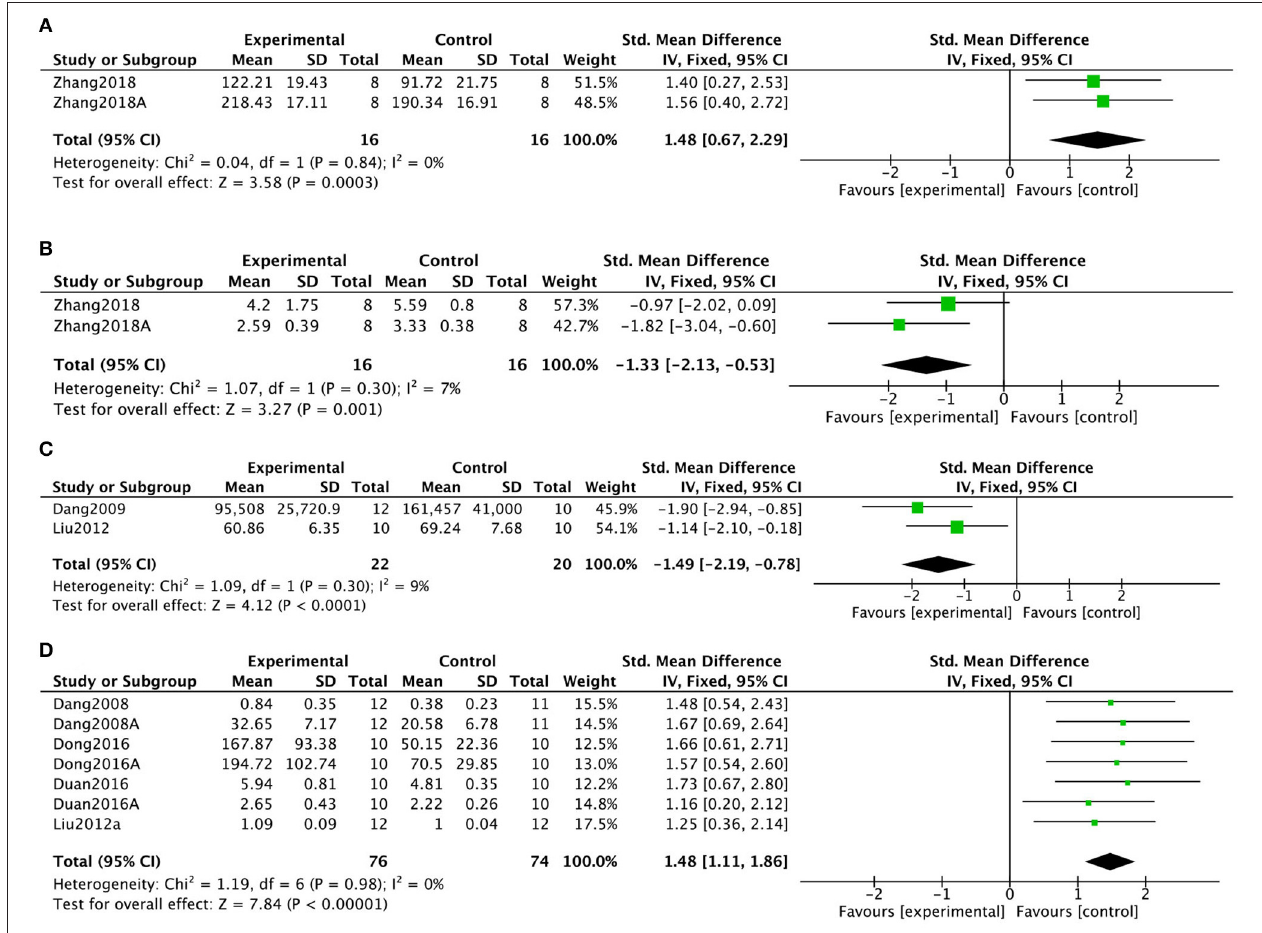
FIGURE 6 | Forest plot showing that KXS increased SOD levels (A) , decreased MDA levels (B) , decreased AchE activity (C) , and increased BDNF levels (D) compared with controls in depression models.